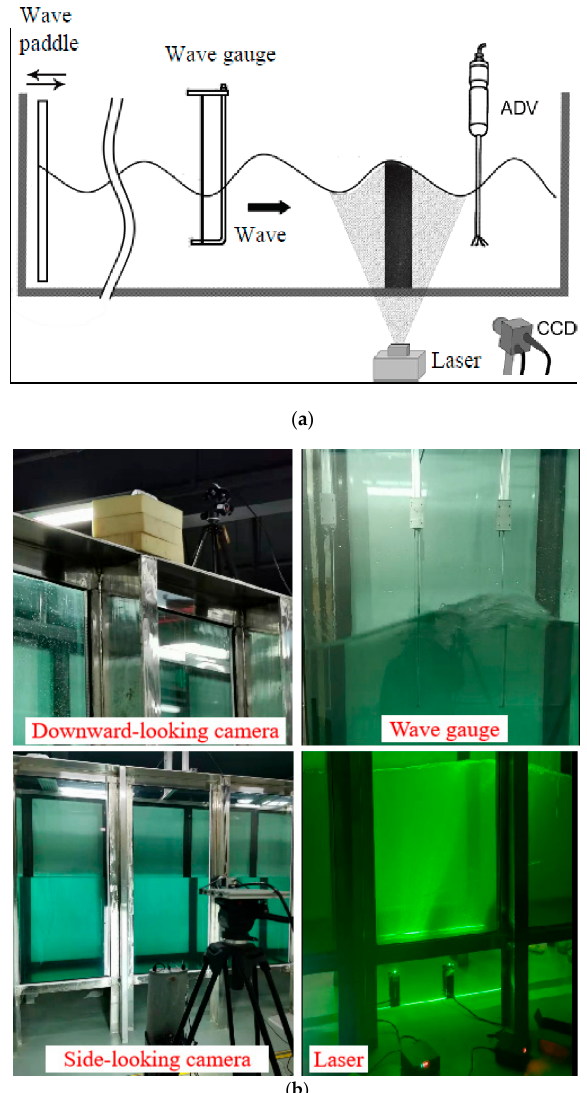
Figure 1. Conceptual schematic of the experiment conducted at the laboratory facility. The water tank is shown in ( a ), and the experimental device is shown in ( b ).